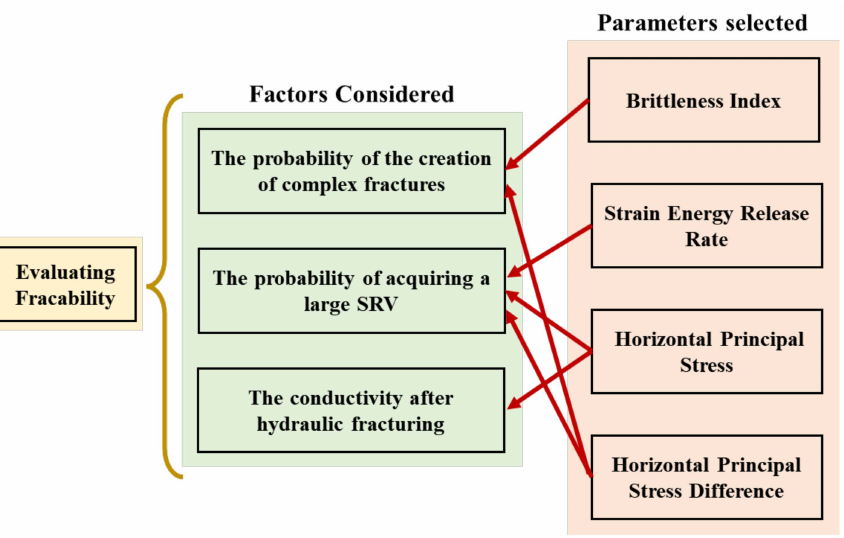
Figure 1. Flow chart of selection of the fracability evaluation parameters in this study, with arrows indicating that the parameters selected have an effect on the factors